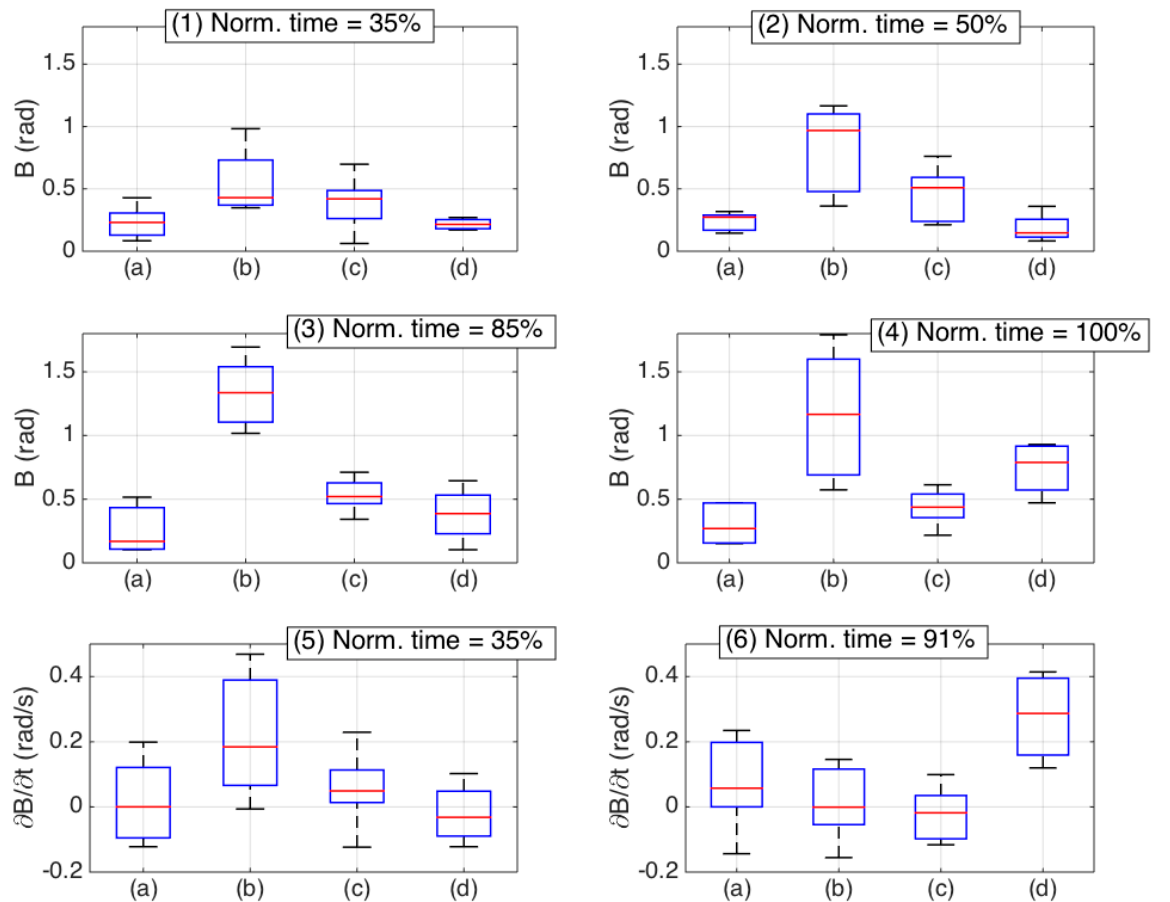
Figure 13. Box plots showing the most important metrics for epidural insertion classification. Each chart shows a different metric obtained for B or ∂ B / ∂ t at a different normalized time. ( a ) Straight insertion; ( b ) large curvature; ( c ) reduced bending; ( d ) failed insertions. Box plots show median value (red), 25th and 75th percentiles (blue box), minimum and maximum values (black error bars). No outliers were identified. ( 1 ) B values for normalized time = 35%; ( 2 ) B values for normalized time = 50%; ( 3 ) B values for normalized time = 85%; ( 4 ) B values for normalized time = 100%; ( 5 ) ∂ B / ∂ t values for normalized time = 35%; ( 6 ) ∂ B / ∂ t values for normalized time = 91%.